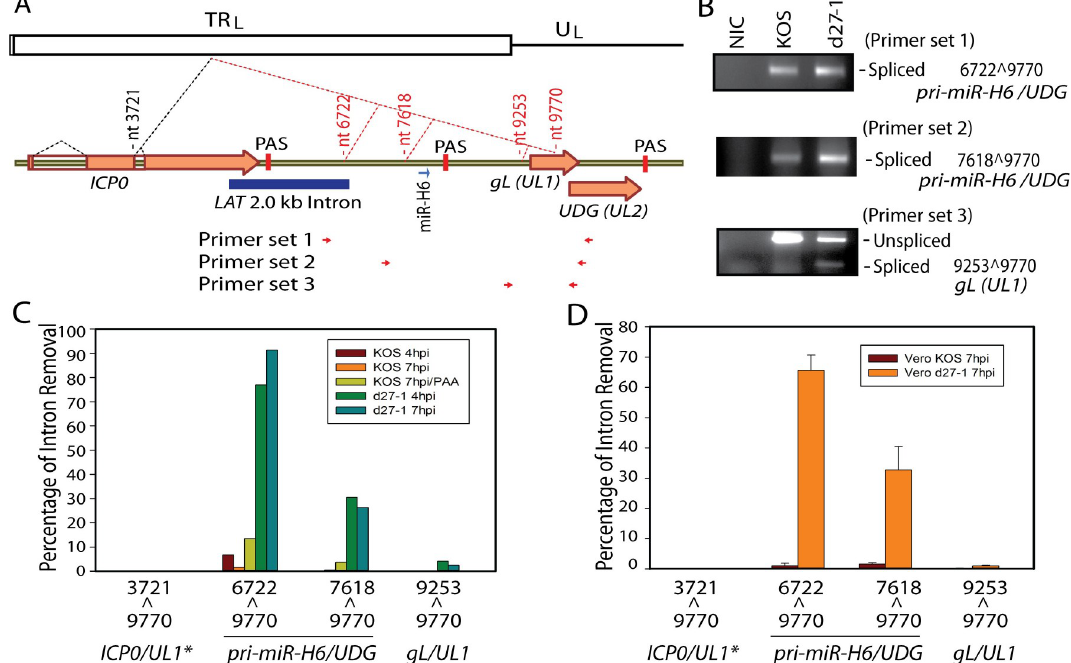
Fig 6. Latently and acutely expressed miR-H6 is encoded by alternatively spliced transcripts for which pre-mRNA splicing is regulated by ICP27. ( A ) Diagram showing the gene structure of the ICP0 , LAT , miR-H6 , UL1 and UL2 region. ICP0 , miR-H6, and LAT are expressed from the repeat regions (shown as the terminal repeat TR L in the diagram). UL1 ( gL ) and UL2 ( UDG ) share the same PAS and are expressed from the unique long region (U L ). Primary LAT (not illustrated in the diagram) is transcribed antisense of ICP0 and pri-miR-H6 . The novel splice sites identified are numbered in red. The LAT TATA box is approximately 45 bp upstream of the novel 5’ss nt 7618 (relative to pri-miR-6/gL/UDG). A PAS is mapped approximately 724 bp downstream of the 5’ss nt7618. The relative locations of primers used in panel (B) are labeled on the bottom of the diagram. ( B ) The splice variants for pri-miR-H6/gL/ UDG were confirmed by RT-PCR in cells infected with d27-1 or KOS. RT-PCR was performed using the primer sets and the same cDNA prepared for sequencing from KOS and d27-1 infected HEK-293 cells (7 hpi). The PCR bands corresponding to the spliced and unspliced products were cloned and the splice junction sequences were confirmed by DNA sequencing. ( C ) Quantitative analysis of splicing efficiency of the splice junctions mapping to the ICP0 , miR-H6 and UL1/2 region using the RNA-Seq data obtained from infected HEK-293 cells. � The splicing efficiency of ICP0/UL1, a recently reported splice variants, is too low to be detected by this quantitative analysis ( < 0.03% of the ICP0 exon 2 junctions 3721^3861/3864). ( D ) Quantitative analysis of splicing efficiency of the splice junctions mapping to primary miR-H6-UL1 region using the RNA-Seq data obtained from infected Vero cells confirms the observation in infected HEK-293 cells.